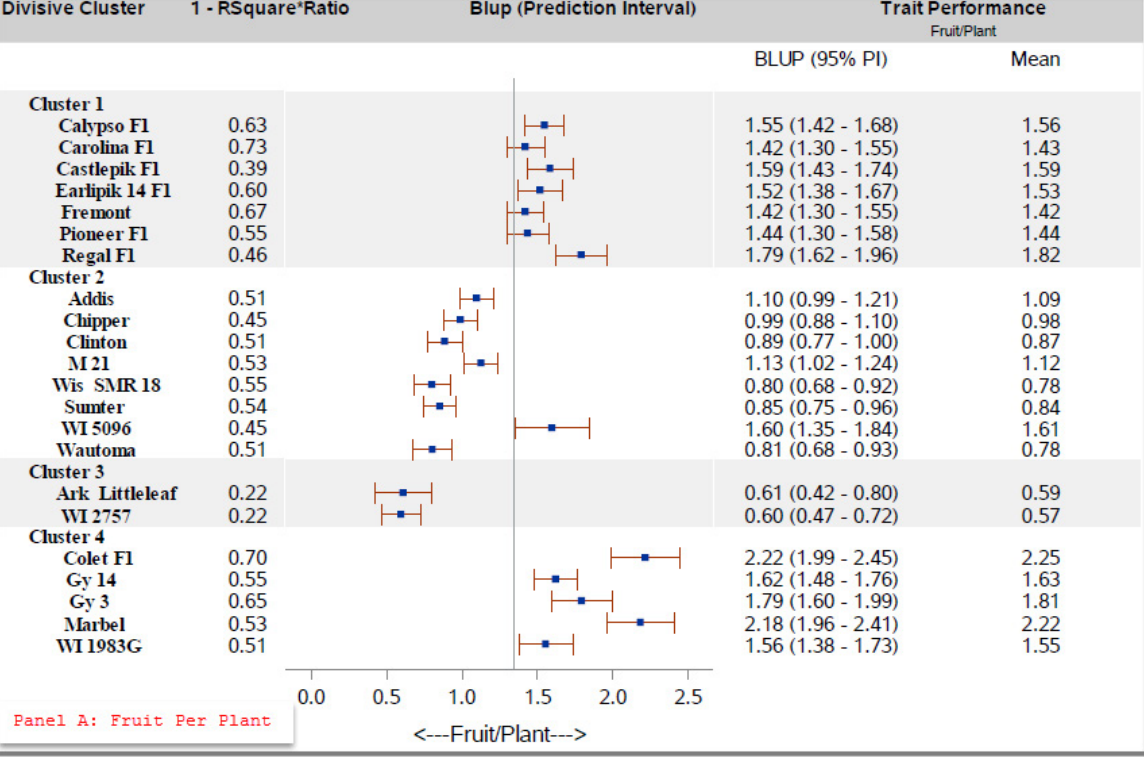
Figure 6: Divisive cluster, 1-R 2 ratio, forest plot of BLUP along with 95% prediction interval, mean, BLUP and 95% prediction interval of 22 cucumber genotypes tested in 3 years and 24 environment for fruit plant -1 (Panel A). Vertical line on x-axis (horizontal scale) represent trait mean across